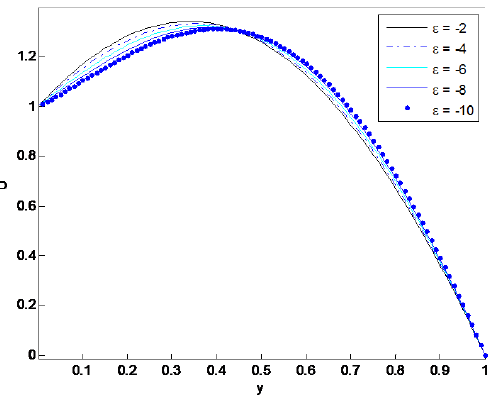
Figure 11: Temperature profile for different values of variable ther- mal conductivity ε ( Br = 0.2 , S = 0.4 , Gre = 10 , λ = −0.3 , d = 0.2 , q = 1